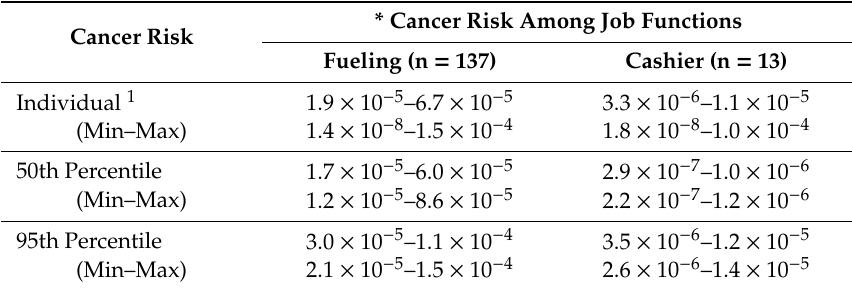
Table 3. The average lifetime cancer risk classified by job